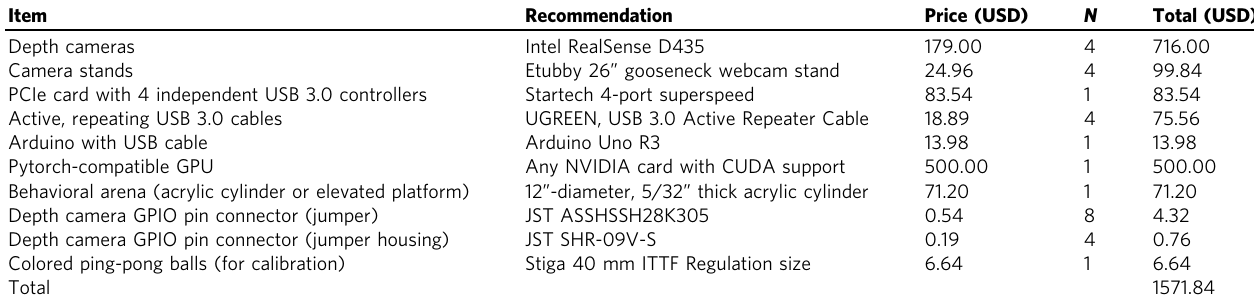
Table 1 Necessary hardware. Item Depth